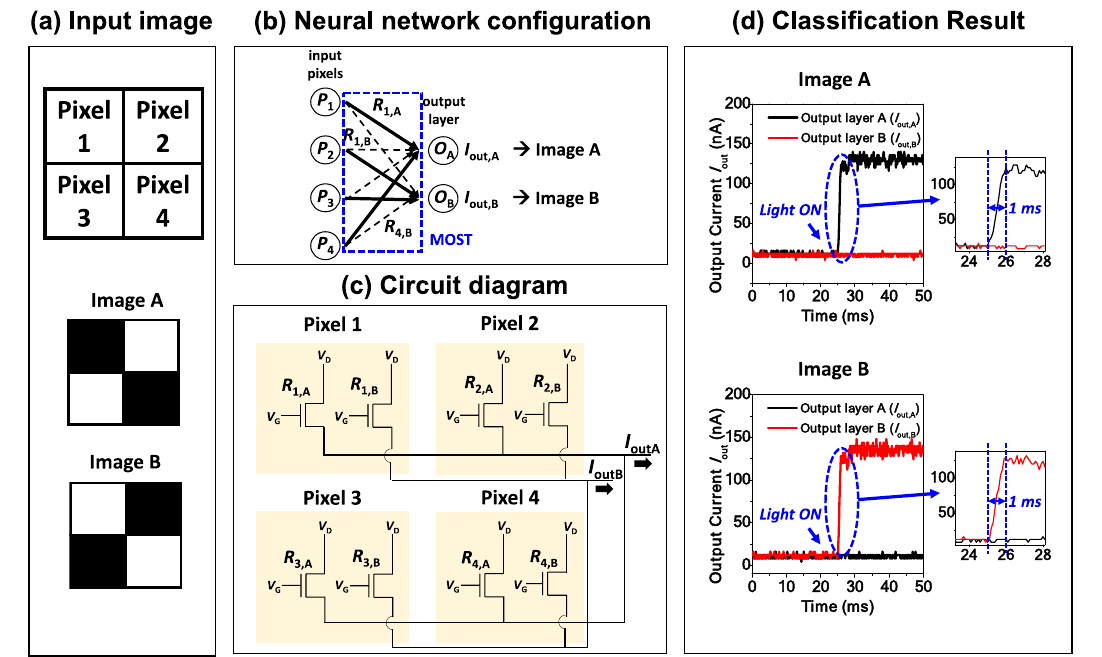
Figure 4. Demonstration of hardware-based pattern recognition. ( a ) Two input images ‘A’ (off-diagonal) and ‘B’ (diagonal), which are composed of 2 × 2 black-and-white pixels. ( b ) Neural network and ( c ) Circuit diagram for the 2 × 2 pattern recognition. They are composed of eight MOSTs with each tunable photoresponsivity represented as ‘ R ’. ( d ) Measured classification data of the off-diagonal and diagonal patterns. By comparing two output currents ( I out,A and I out,B ), fast classification within 1 ms was achieved with low power consumption under 150